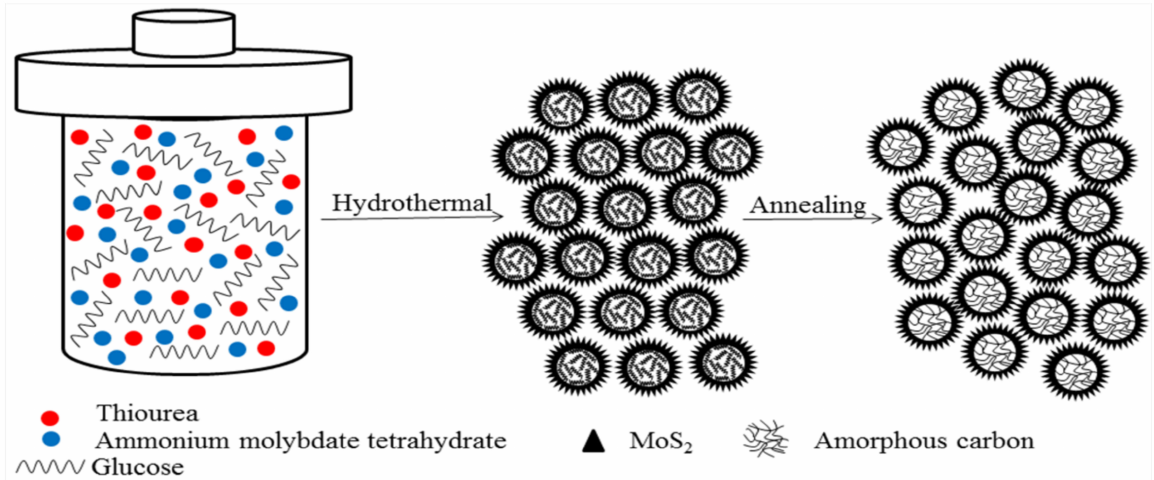
Figure 1. Schematic illustration of the formation mechanism of the hierarchical MoS 2 /C quasi-hollow